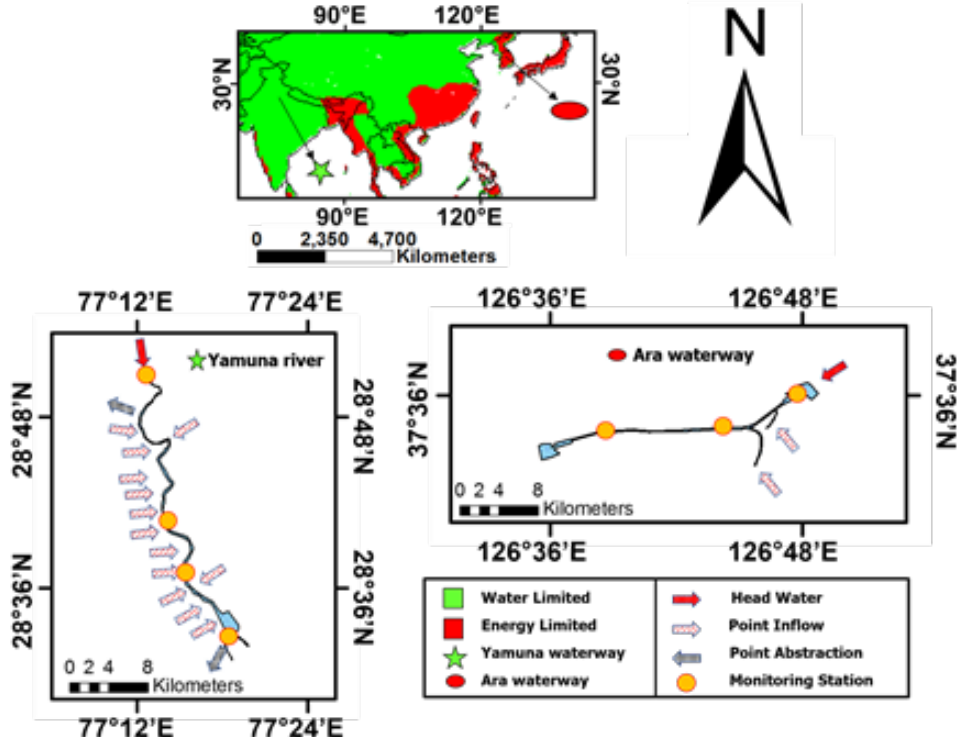
Figure 1. Study area